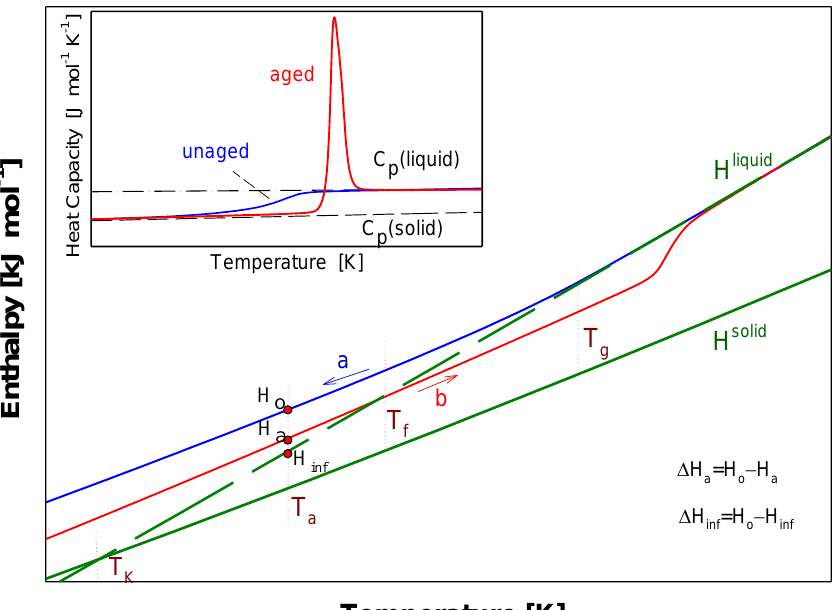
Figure 4. Scheme of the analysis of experimental enthalpy recovery of polymeric material in the frame of equilibrium enthalpies (H solid , H liquid ) versus temperature. The insert shows the aged and unaged, experimental heat capacity carried out by the differential scanning calorimetry (DSC) measurement. The solid, C p (solid), and liquid, C p (liquid), heat capacity are presented as equilibrium lines of references.